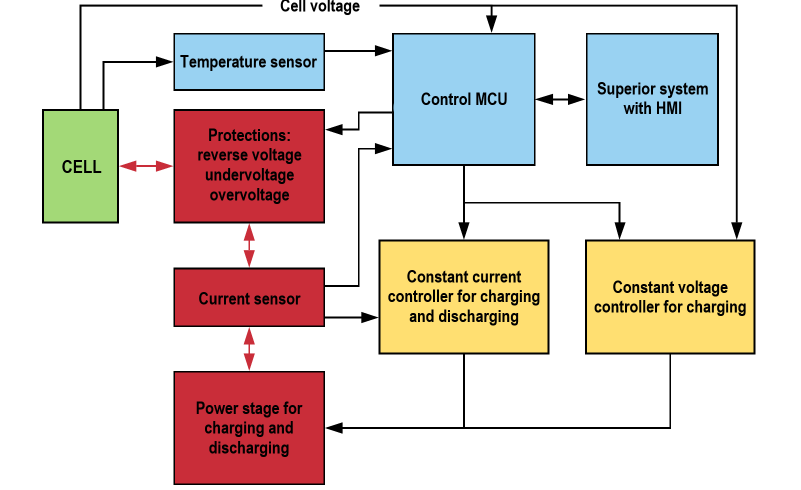
Figure 4. Testing system